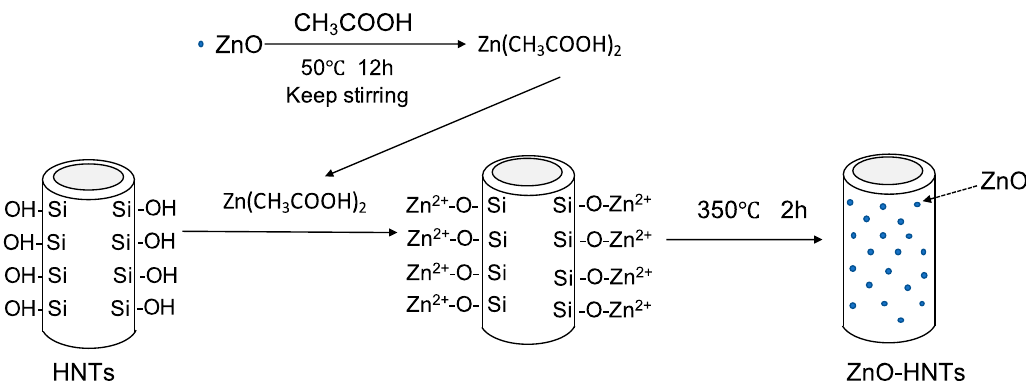
Figure 1. Facile synthesis and characterization of zinc oxide (ZnO) nanoparticles grown on halloysite nanotubes for enhanced photocatalytic properties.